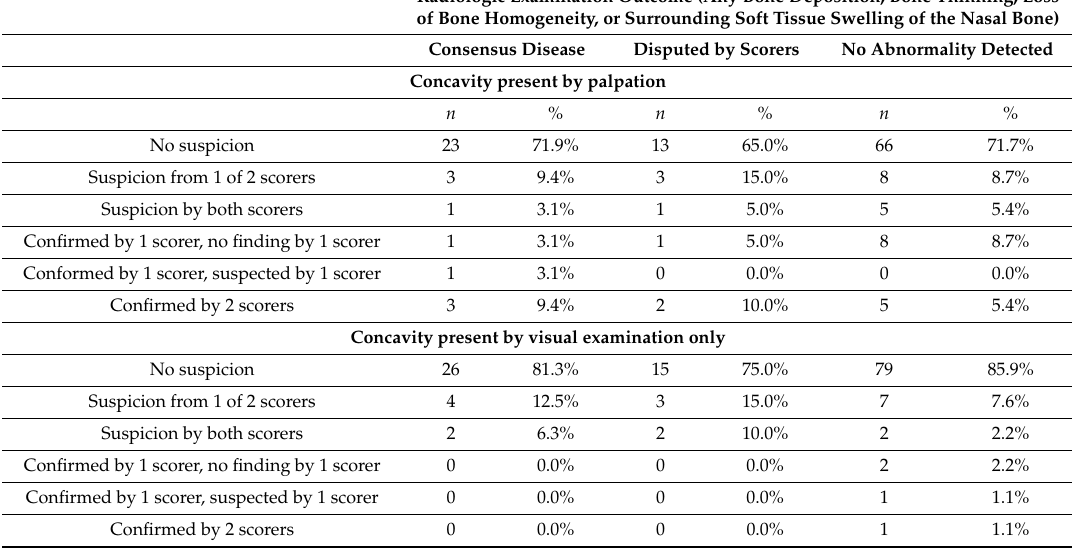
Table 8. Relationship between any radiographic lesion being noted and the concavity physical exam findings of the mandible of 144